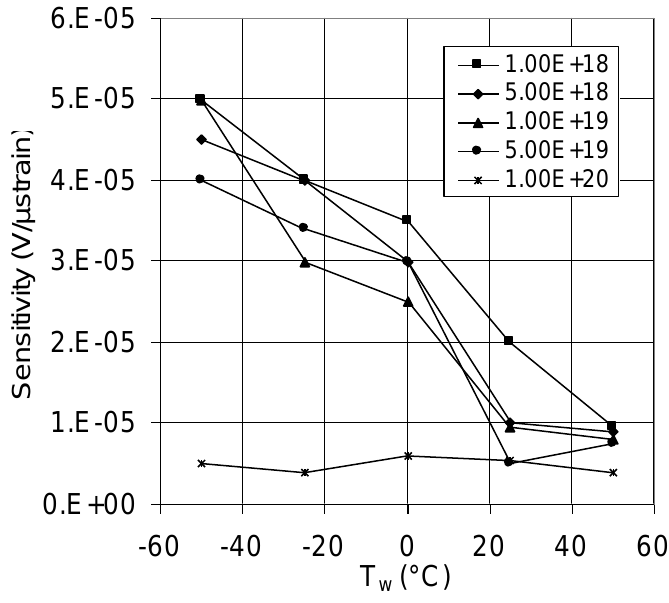
Figure 24. Temperature effect on the sensor sensitivity at different doping concentrations.